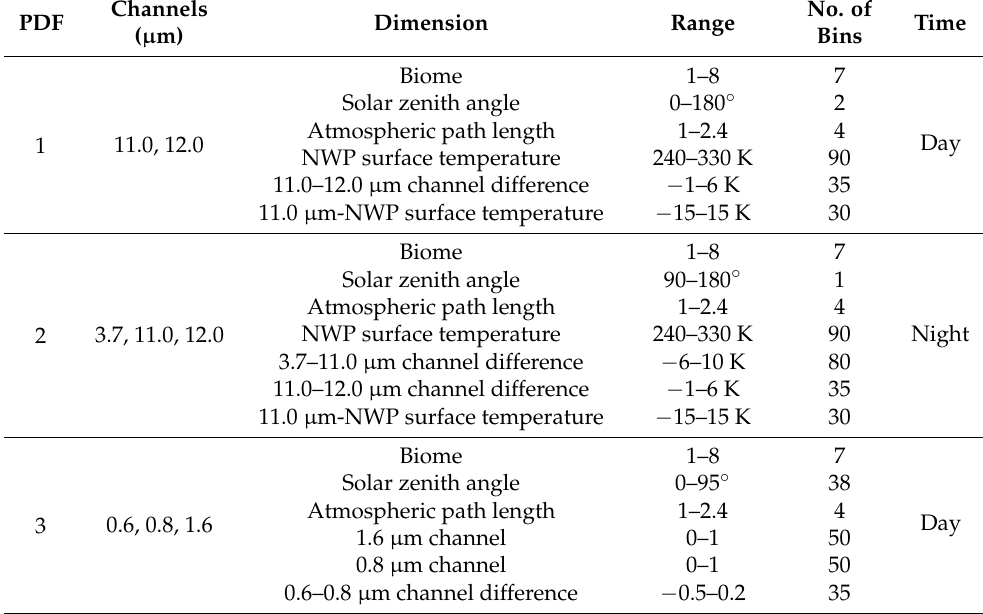
Table 1. PDF LUTs used to determine the probability of ‘not clear’ conditions given the observations and background state vector.